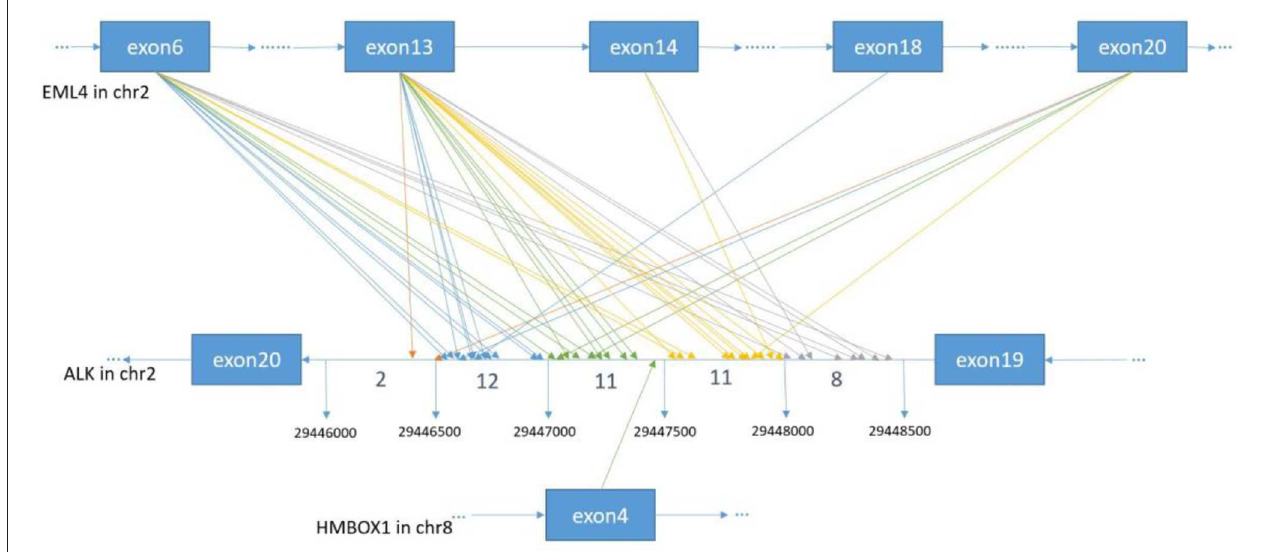
FIGURE 2 | The breakpoint distribution in ALK and the respective fusion partners. Each arrowed line represents one fusion event. The exact breakpoints of ALK in GRch37 are shown in the middle panel, while the fused exons of ALK fusion partners are shown in the top and bottom panels, respectively. The sequence of ALK is exhibited reversely (from right to left), while the sequences of EML4 and HMBOX1 are represented in the forward direction. The genomic region of ALK between 299446000 and 29448500 on Chromosome 2 is divided into regions every 500 bp. Breakpoint position in ALK locate between 29446000 and 29446500 with an orange arrow, between 29446501 and 29447000 with a blue arrow, between 29447001 and 29447500 with a green arrow, between 29447501 and 29448000 with an yellow arrow, between 29448001 and 29448500 with a gray arrow.